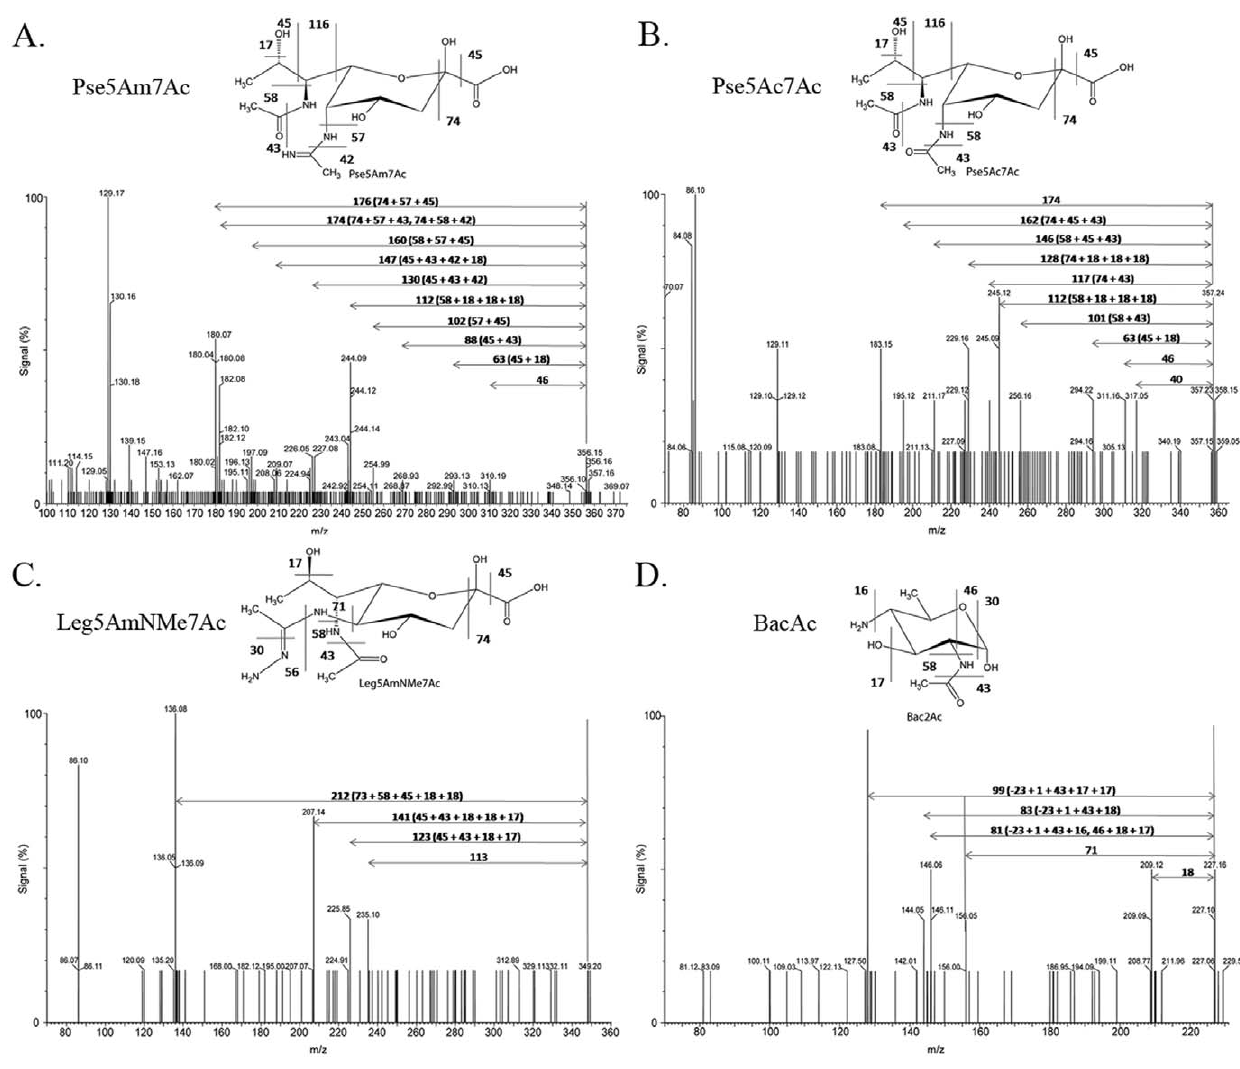
Figure 10. Mass spectrometry analysis of the sugars extracted from GP candidates by acid hydrolysis. The sugars were analyzed by LC- MS/MS. In each panel, the molecular structure of the expected sugar is shown above the MS/MS spectrum, with the expected fragmentation pattern and associated mass loss. The MS/MS spectra are annotated with the total mass loss intervals and with mass loss combinations that lead to the size of the observed peaks. All spectra are shown as sodium adducts. Panel A: Pse5Am7Ac. Panel B: Pse5Ac7Ac. Panel C: Leg5AmNMe7Ac. Panel D: Bac2Ac.